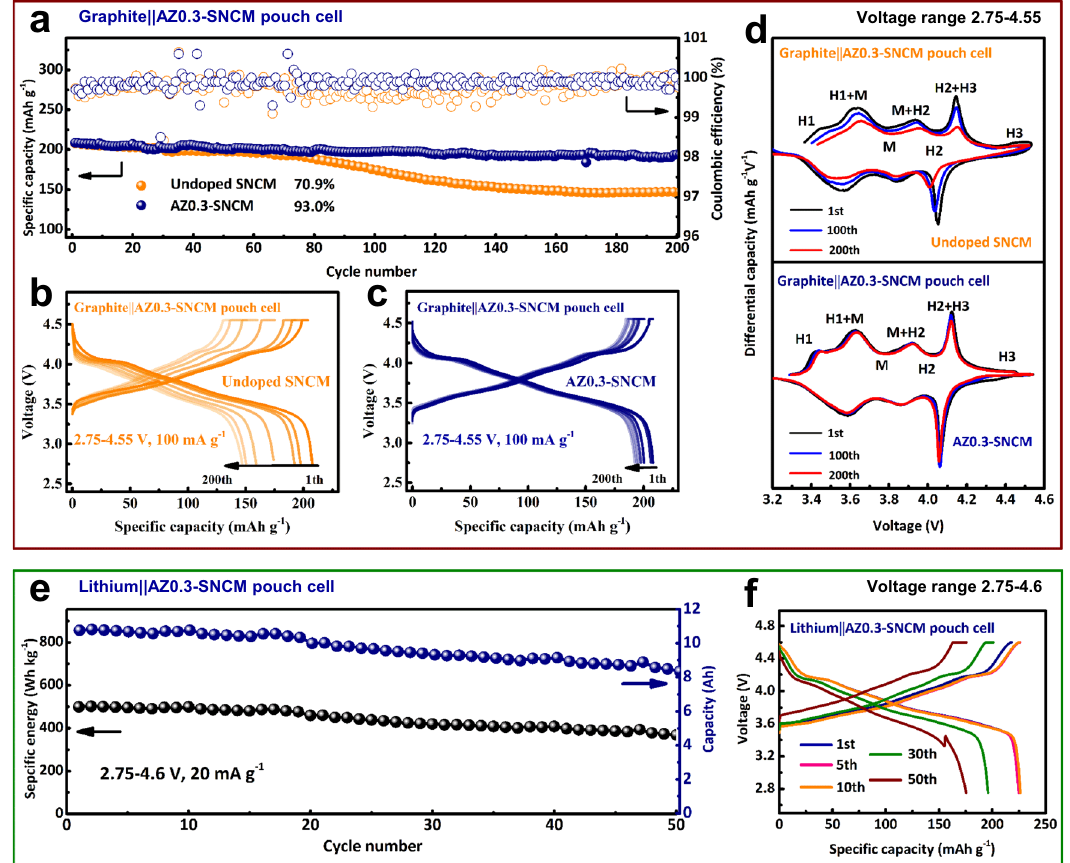
Fig. 3 Electrochemical characterization of pouch-type full-cell at 25 °C. (1.1 M LiPF 6 in ethyl carbonate/ethyl methyl carbonate/diethyl carbonate (EC/EMC/DEC, 3:5:2 in volume) + 1 wt% vinylene carbonate is used as the electrolyte) . a Cycling performance of full cells with undoped SNCM or AZ0.3- SNCM as cathode and graphite as anode at 0.5 C (100 mA g − 1 ) within the voltage range of 2.75 – 4.55 V. Charge/discharge curves for undoped SNCM ( b ) and AZ0.3-SNCM ( c ) at different cycles. d The d Q d V − 1 curves for undoped SNCM and AZ0.3-SNCM at various cycles. Cycling property ( e ) and corresponding charge/discharge curves ( f ) of AZ0.3-SNCM||Li foil pouch full cells within the potential window of 2.75 – 4.6